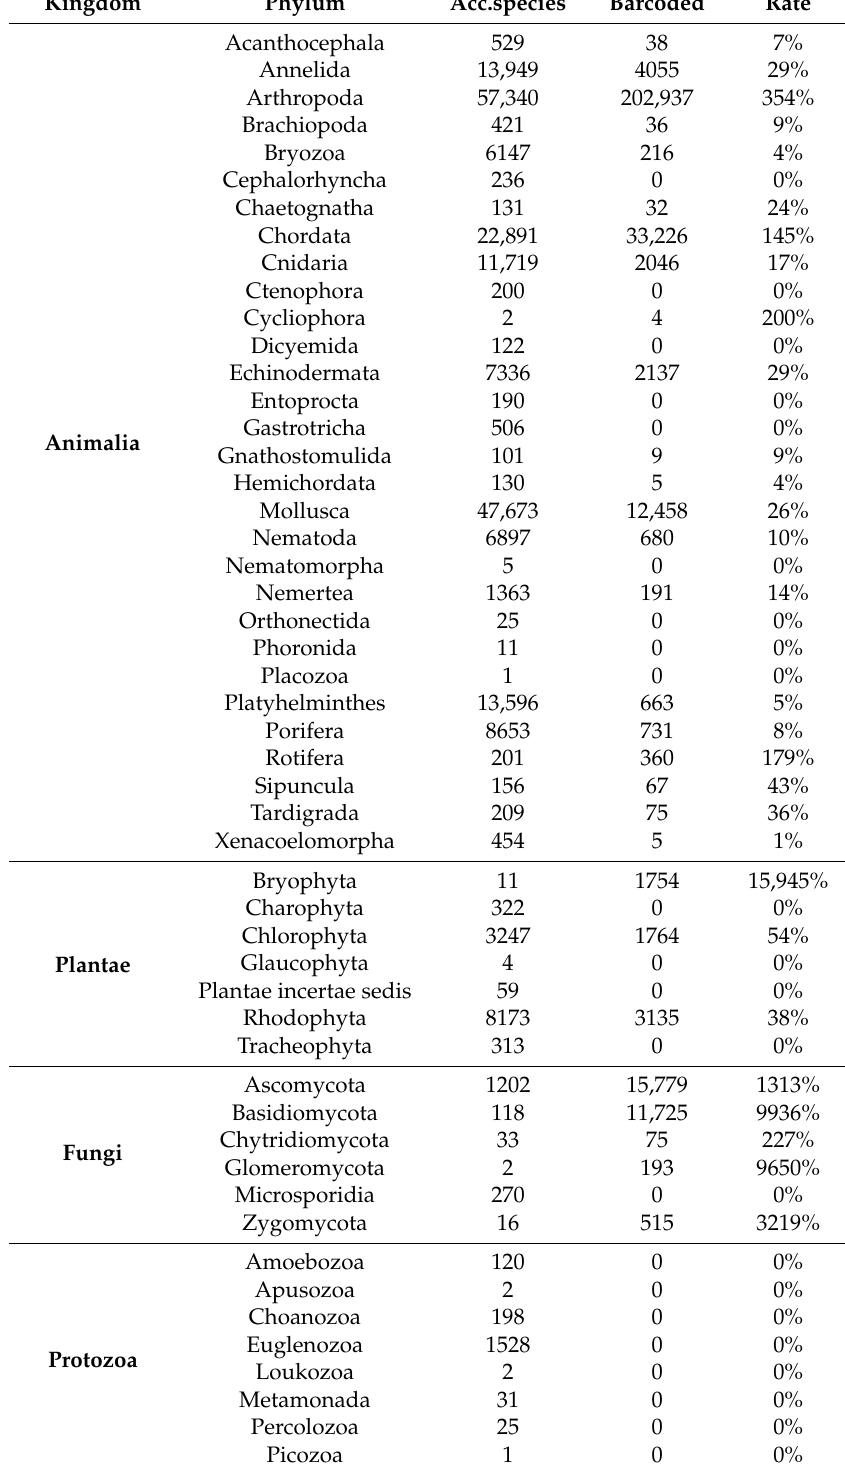
Table 1. Table of accepted species, barcoded species, barcoding rate in BOLD and WoRMS. Kingdom Phylum